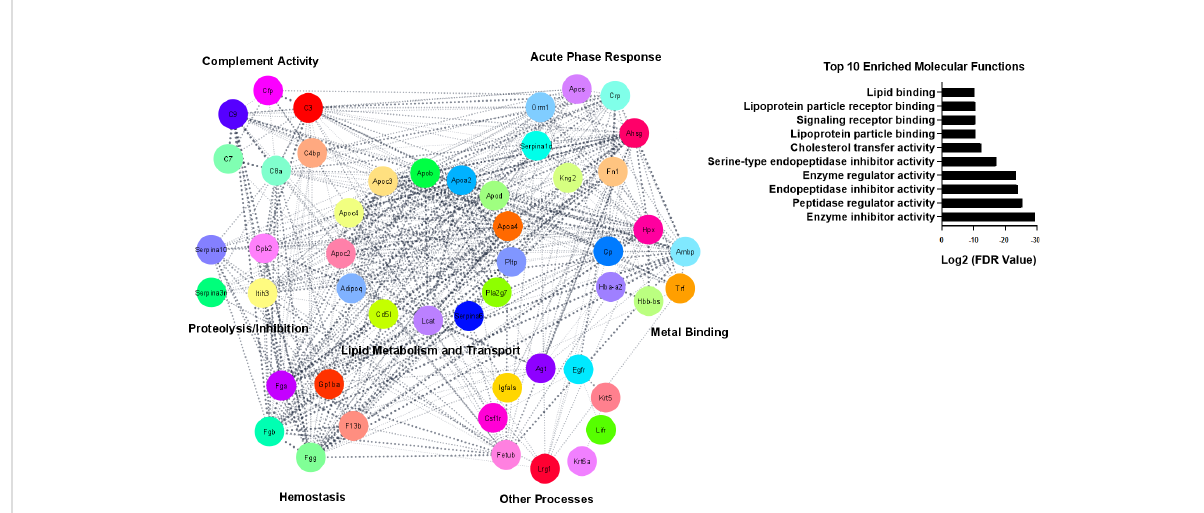
FIGURE 4 Protein interaction network displaying differentially abundant proteins, excluding immunoglobulins. Fifty out of 58 identities composed the interactome. Cytoscape Software v. 3.9.1, underpinned by STRING query tool for interrogation of the Mus musculus database, was used to visualise the generated network. Con fi dence cutoff score was set to > 0.4. Cytoscape also provided the Top 10 enriched molecular functions related to this network. The signi fi cant terms and pathways were selected with the threshold of adjusted Log2 FDR < -10. Abbreviations for protein identities are shown in Supplementary Table